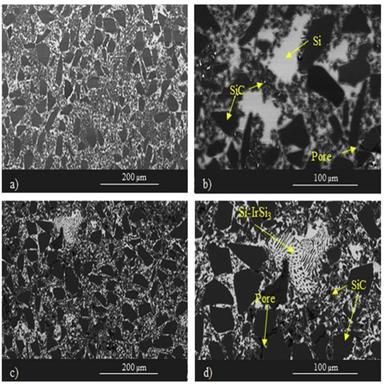
X-ray diffraction patterns of composite materials: a) SiC/Si produced at T = 1450 °C and b) SiC/IrSi3 produced at T = 1350 °C.